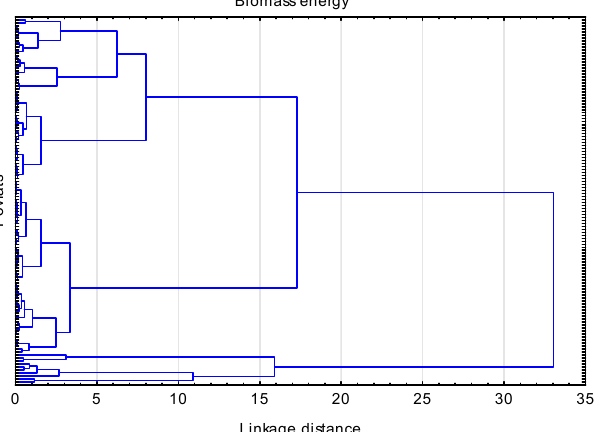
Figure A3. Dendrogram for poviats agglomeration, Ward linkage method with Euclidean distance–biomass energy.